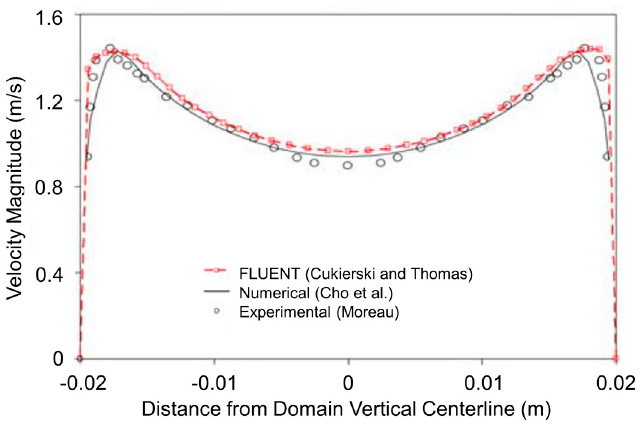
Figure 8. MHD model validation: comparison of velocity profiles in the test channel domain [61].